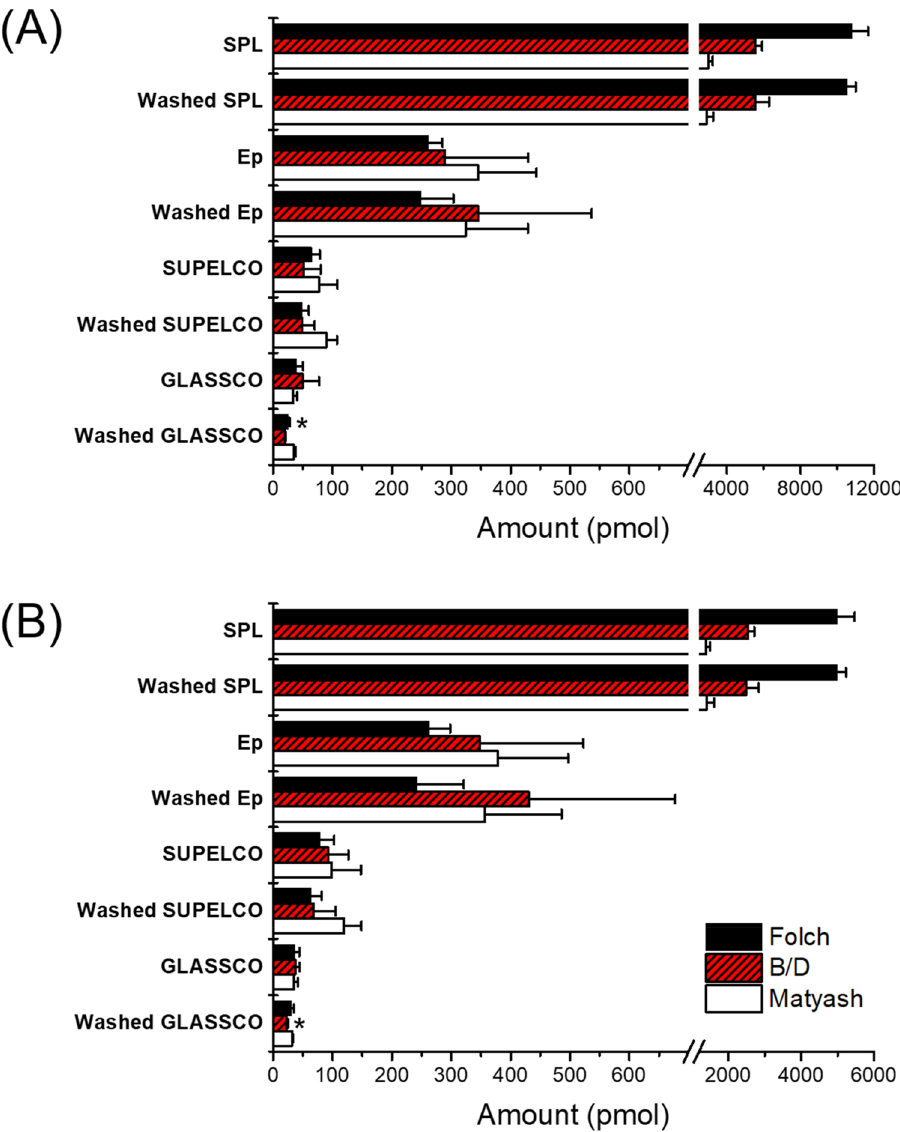
Figure 3. A comparison of the amount of ( A ) PA and ( B ) SA extracted from all combinations of the four sample tubes (SPL, Ep, SUPELCO and GLASCO) and three FFA extraction methods (Folch, B/D and Matyash) studied. Data are shown as the mean ± SD ( n = 6). Asterisks denote statistically significant differences compared with the non-treatment by the Welch’s t -test (* P < 0.05).